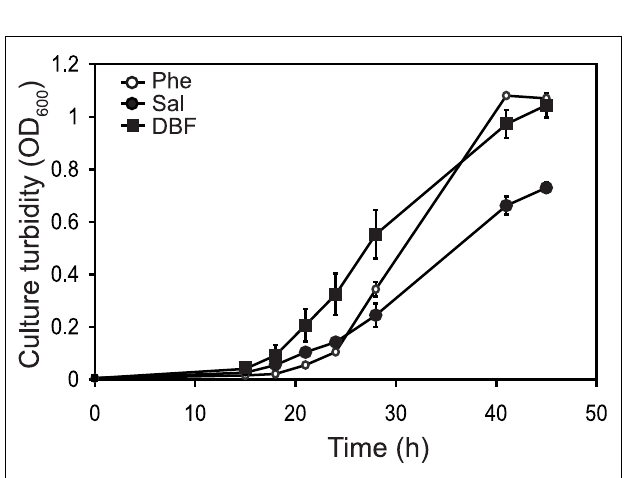
FIGURE 3 | Growth of S. wittichii RW1 on minimal media (MM) with PHE (open circles), SAL (closed circles), or DBF (closed squares) as sole carbon and energy